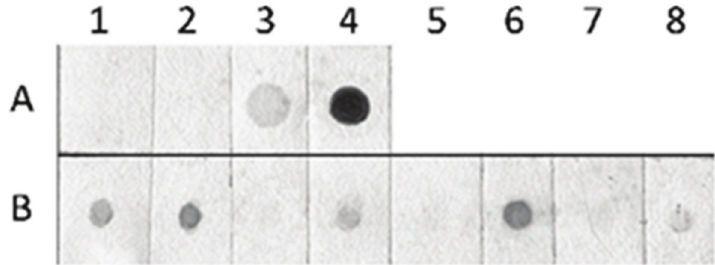
Figure 2. Immuno-dot blot using antibody specific for 5-hydroxymethylcytosine. Lane A represents 100 ng of methylated DNA from the plasmid pUC (A1), 100 ng of unmethylated DNA from pUC (A2), 625 ng of human genomic DNA (A3), 250 ng of 5-hydroxymethylated DNA from Staphylococcus aureus (A4). Lane B—200 ng of genomic DNAs from D. pulex juveniles (B1, B2), preadults (B3, B4), adults I (B5, B6), and adults II (B7, B8); even numbers—individuals hatched form parthenogenetic eggs; odd numbers—individuals hatched from ephippial eggs.